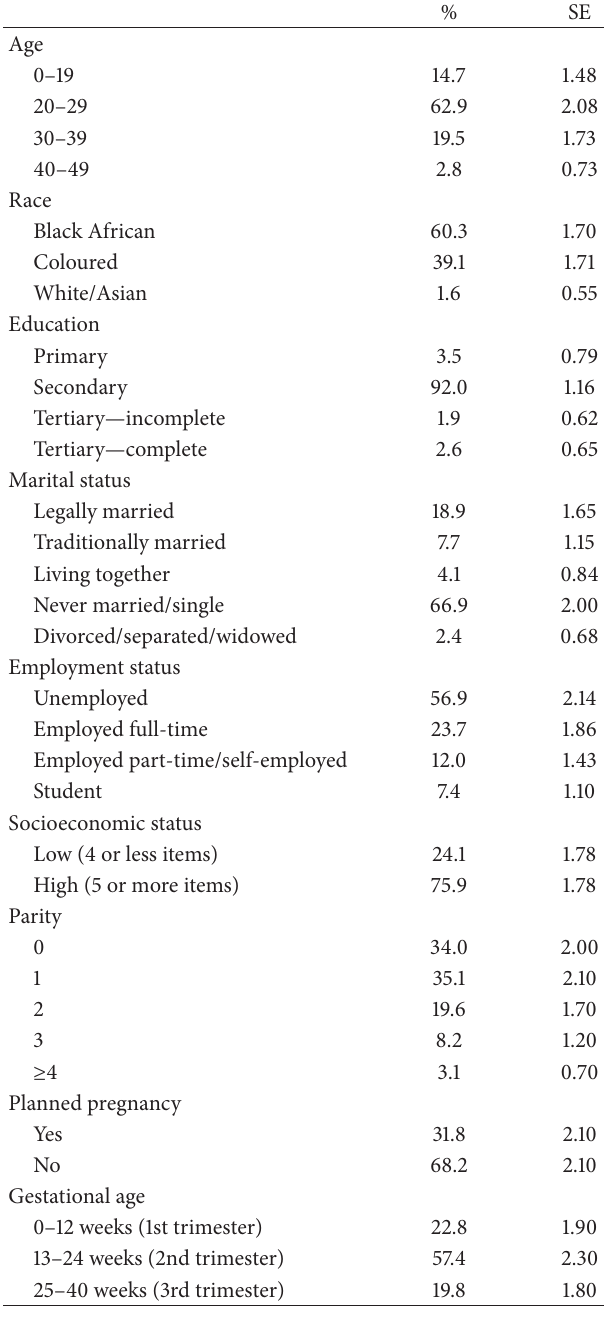
Table 1: Description of sub-sample participant demographic char- acteristics (𝑛 = 684) .